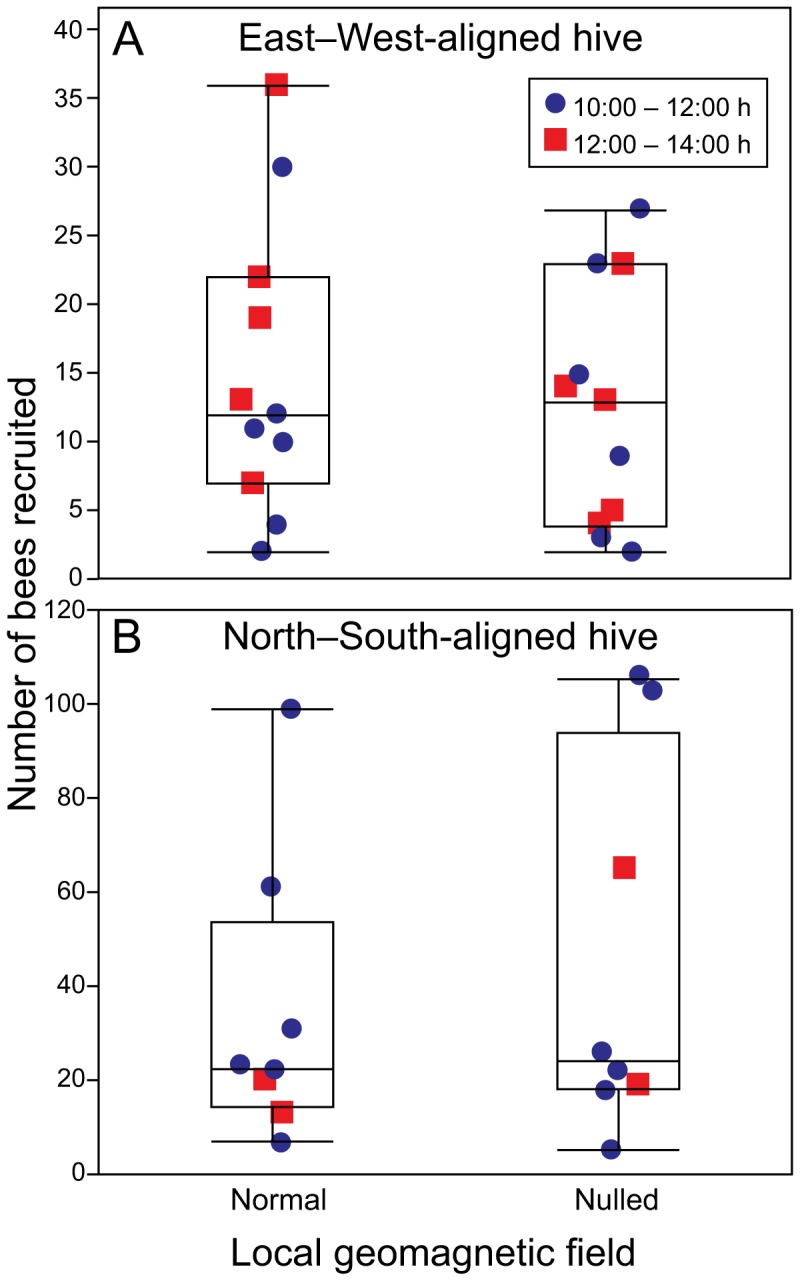
Effect of suppressing the ambient magnetic field on the recruitment success of waggle-dancing bees.Boxplots show the mean, median lower and upper quartiles, and ± whiskers (minimum/maximum data points) of the number of honeybee nest mates recruited in morning and afternoon sessions to a feeding station in the presence (control session) or absence (treatment session) of the ambient magnetic field (see Fig. 1B, C2). The presence or absence of the ambient magnetic field had no effect on the number of recruits irrespective of the alignment of the observation hive (East–West: linear mixed effect model analysis; F1,10 = 0.9548, p = 0.35; North–South: linear mixed effect model analysis; F1,7 = 0.9660, p = 0.3).